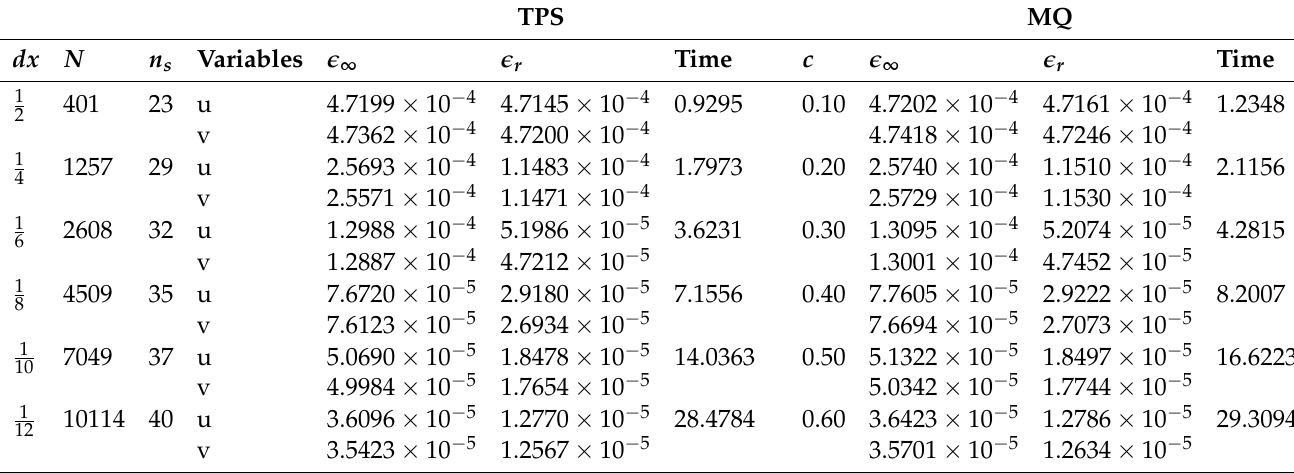
( a ) ( b ) Figure 5. Sparsity pattern for Example 2 with ( a ) TPS and ( b ) MQ by taking dx = 1 n c = 35. Table 4. Error estimates and CPU times of Example 2 by letting τ = 0.5 ( dx ) 2 for different values of dx and stencil size n s .